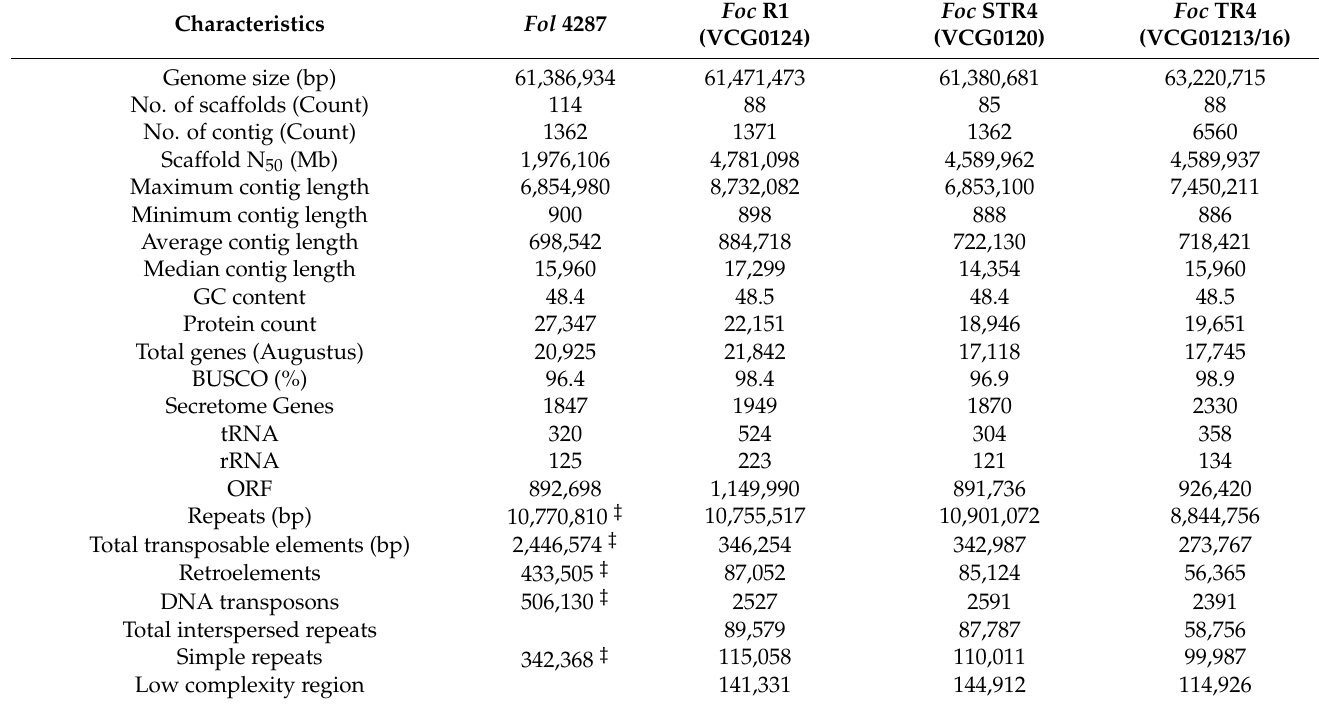
Table 1. Summary of genomic and predicted features of reference and assembled genomes of Fol 4287 and Indian Foc races.